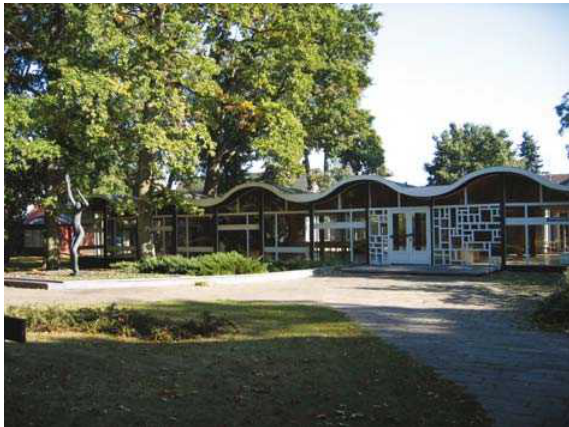
Fig 5. Reeding-hall. Arch A. Čepys, 1966. Palanga, Vytautas st